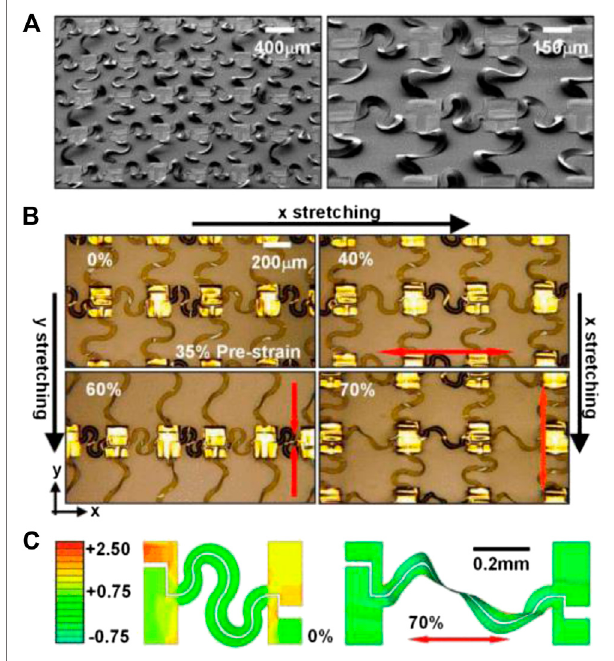
FIGURE 8 | (A) SEM image of an array of stretchable CMOS inverters with noncoplanar bridges that have serpentine layouts (left) and magni fi ed view (right) . (B) Optical images of stretching tests in the x - and y -direction. (C) FEM simulation before (35% prestrain) and after (70% applied strain) stretching (Kim et al., 2008). Reproduced with